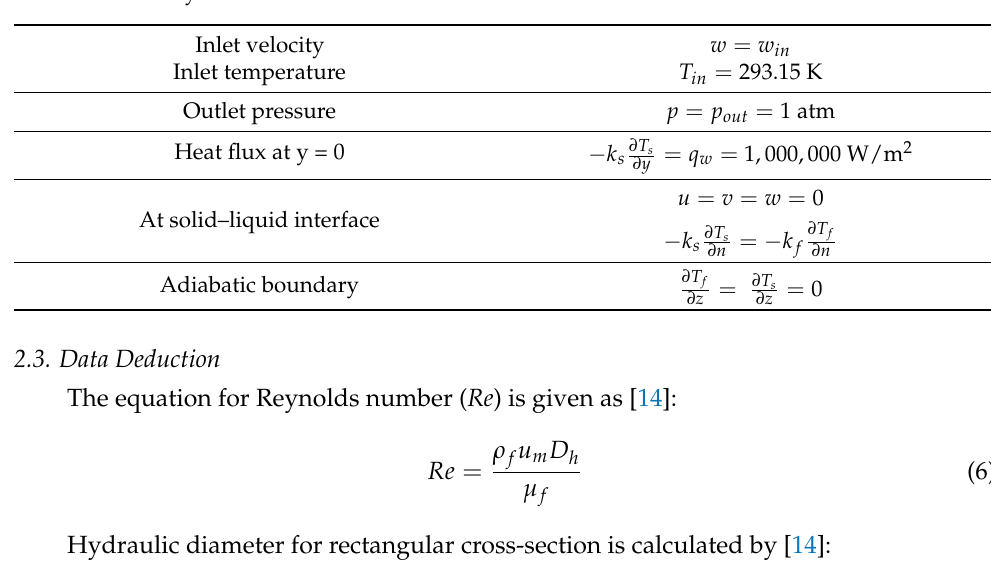
Table 2. Boundary